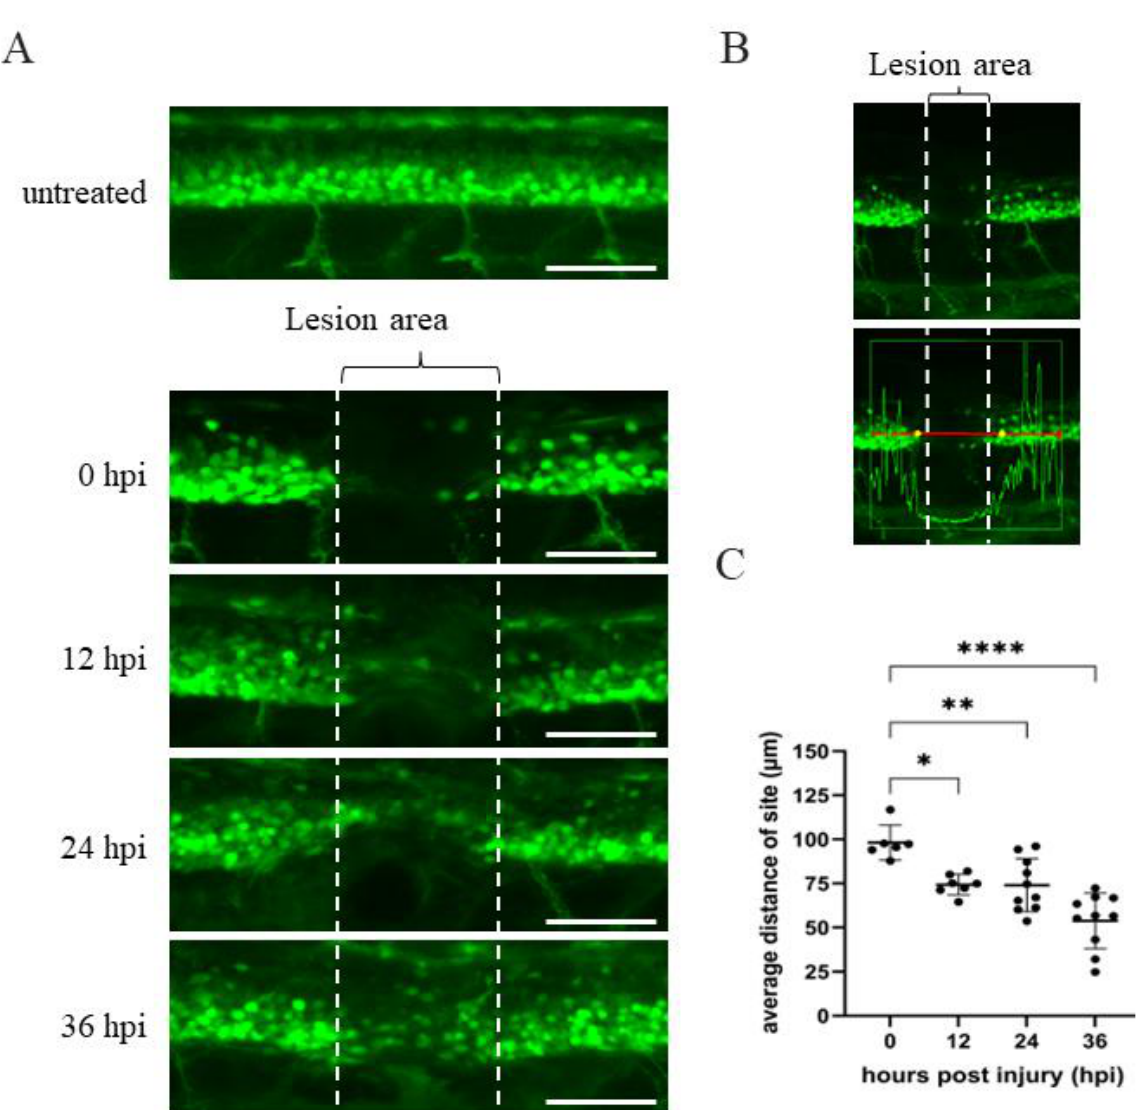
Figure 1. Time course of spinal cord regeneration of Tg(mnx1:GFP) transgenic zebrafish larvae after SCI. ( A ) Spinal cord located at the 17 – 20th segment of Tg(mnx1:GFP) embryos at 48 hpf was crushed, causing SCI. Complete loss of motoneuronal connections in the lesion area around the SCI (indicated by two broken lines) occurred at 0 hpi. Then, spinal cord regeneration from 12 to 36 hpi was shown, compared to uninjured spinal cord. ( B ) Image of SCI -Tg(mnx1:GFP) larvae at 0 hpi used to quantify the length of lesion site (in μ m) using Zen 2010b Sp1 software. The box in the lower panel shows a red line 300 μ m in length. This indicates the detection area with fluorescent cells located at either side of the SCI site, as marked by the vertical white broken line. While the GFP signal within the box could be detected, its intensity dropped at the SCI site. Indeed, the yellow dots mark the place where the strength of the green fluorescence signal dropped off at both sides of the SCI. The length of yellow dots relative to that of the vertical broken white line was measured. Observed by the naked eye, the length of yellow dots was longer than that of SCI site (white broken line). ( C ) Statistical analysis of the distance (in μ m) between the two yellow dots versus temporal regenerative response (in hpi) in SCI- Tg(mnx1:GFP) embryos. Each dataset was obtained from three independent experiments and represented as mean ± SEM. One-way ANOVA was used to perform statistical analysis (* p < 0.05, ** p < 0.01, **** p < 0.0001; ns: not significant). Scale bar: 100 μ m.